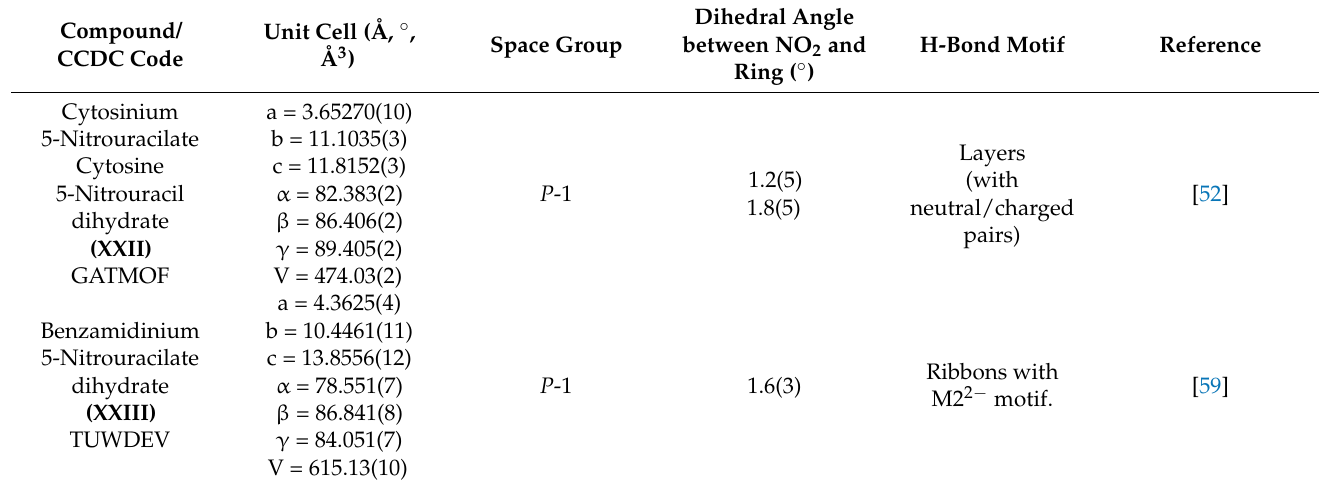
Table 11. Crystallographic data of more 5NU